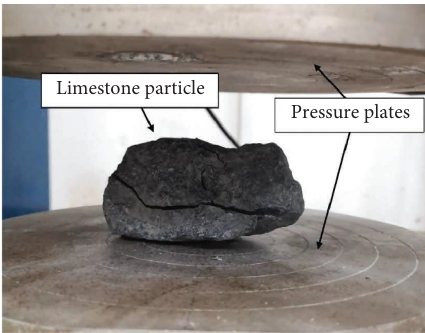
Figure 7: Universal tests.